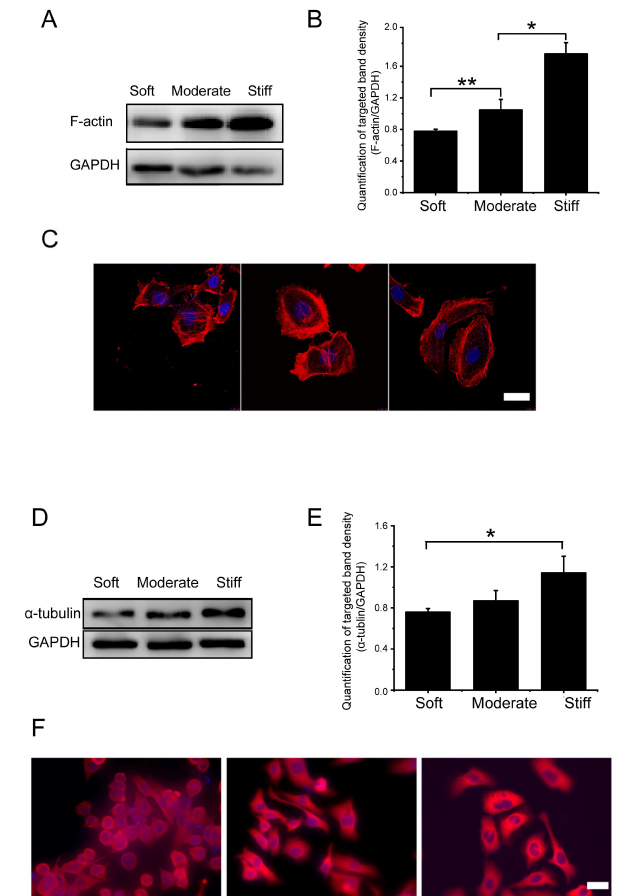
Figure 4. Substrate sti ff ness a ff ects F-actin and α -tubulin expression of hepatocytes cultured on soft, moderate, and sti ff substrates for 48 h. ( A ) Protein synthesis of F-actin was detected by Western blot. ( B ) Band densities were analyzed by Quantity One software. ( C ) Protein synthesis of F-actin was detected by immunofluorescence staining; scale bar = 20 µ m. ( D ) Protein synthesis of α -tubulin was detected by Western blot. ( E ) Band density was analyzed by Quantity One software. ( F ) Protein synthesis of α -tubulin was detected by immunofluorescence staining; scale bar = 40 µ m. Moderate and sti ff groups compared to the soft group. Data presented as the mean ± SEM ( n = 3). * represents p < 0.05; ** represents p <